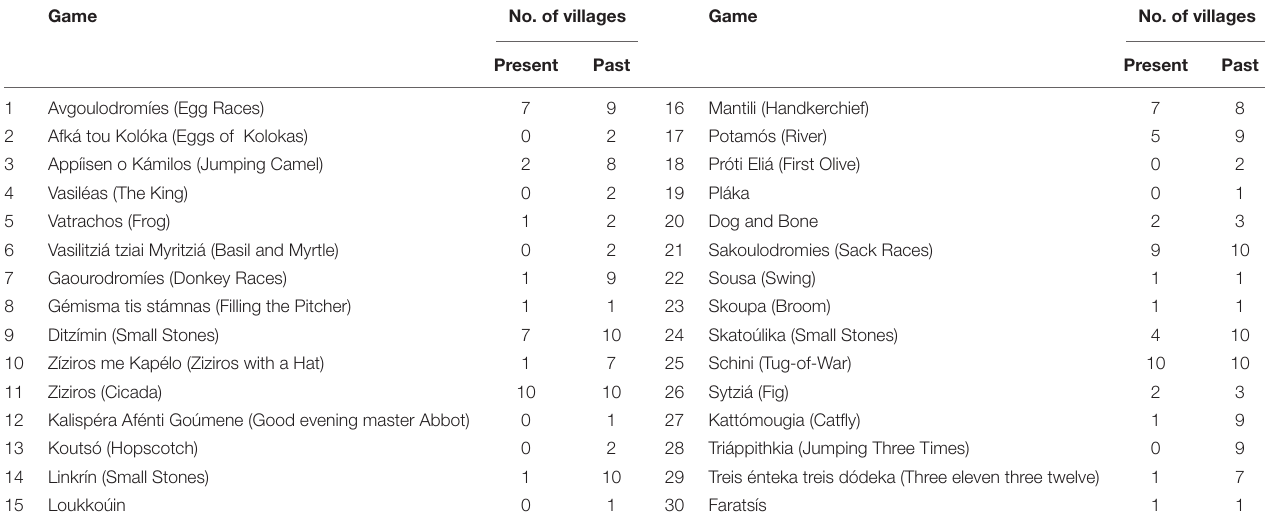
TABLE 1 | Games played in how many villages (present and past).